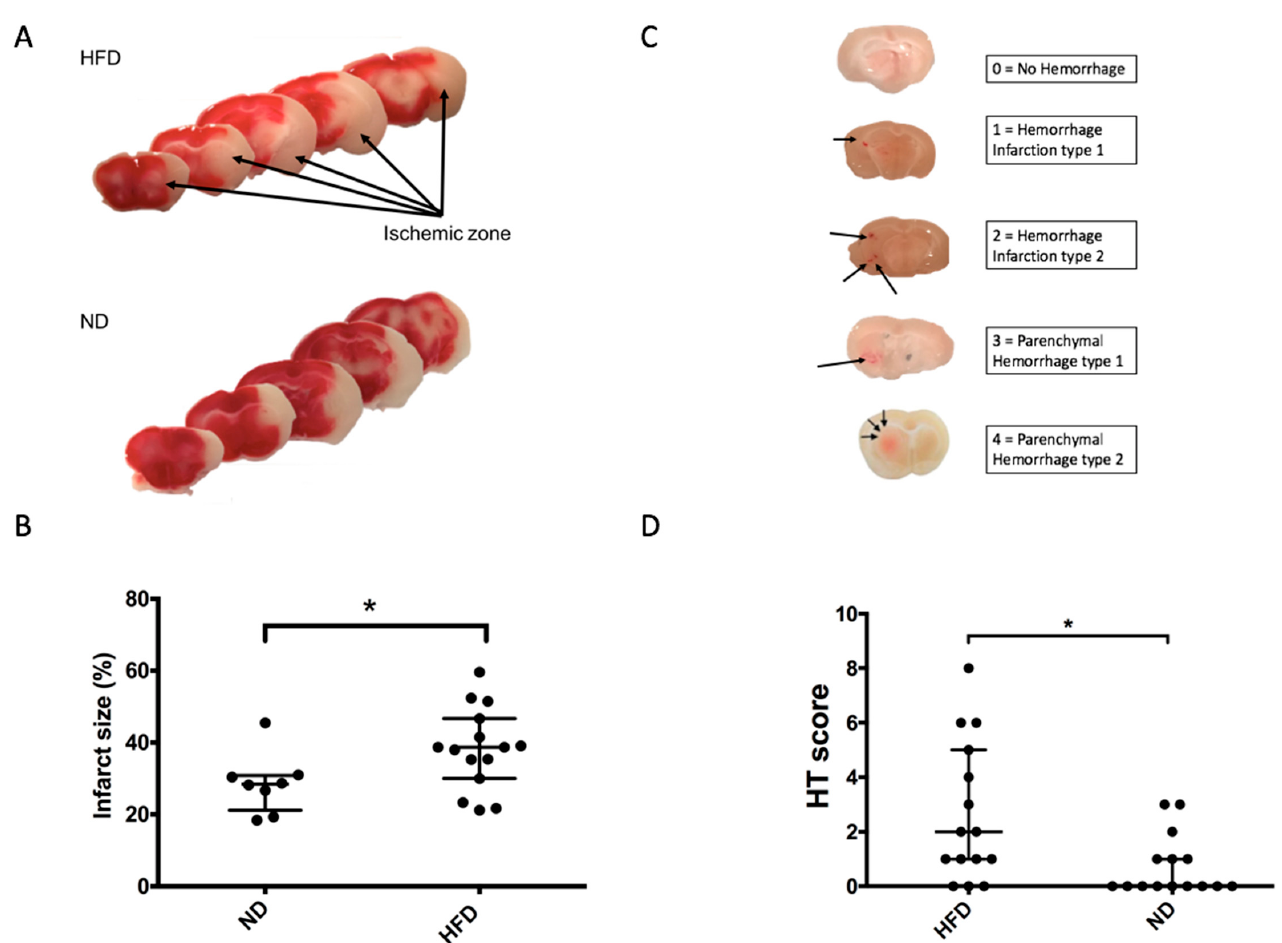
Figure 4. HFD promotes brain injuries during acute stroke. ( A ) TTC staining of coronal brain slice. In red, healthy tissue and in white, ischemic/necrotic zone (non-stained); ( B ) Ischemic volume in % 24 h after reperfusion (HFD: 38.7 (IQR 30–46.7%) n = 15 vs. ND: 28.45 (IQR 21–30%), n = 8); * p = 0.038. All value are median with (IQR); ( C ) Examples of hemorrhagic transformation for the score determination; ( D ) Hemorrhage transformation score 24 h after MCAO in coronal brain slice (total of slice individual score in 5 slices) (HFD group: 2 (IQR 1–5) n = 15 vs. ND 0 (IQR 0–1), n = 15; * p = 0.02). All values are median with (IQR).